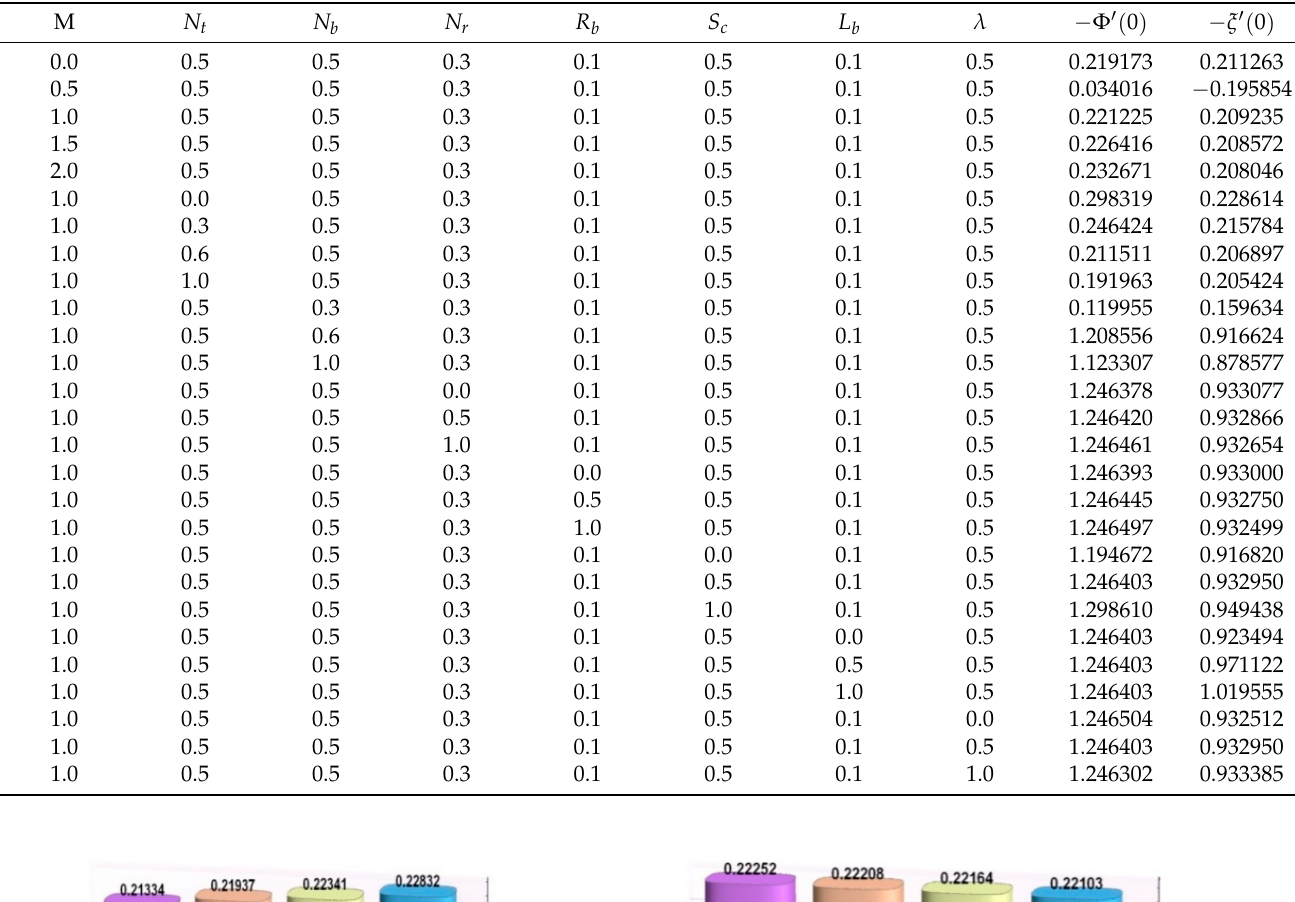
Table 2. Numerical values of Sherwood number and density number against significant parameters.